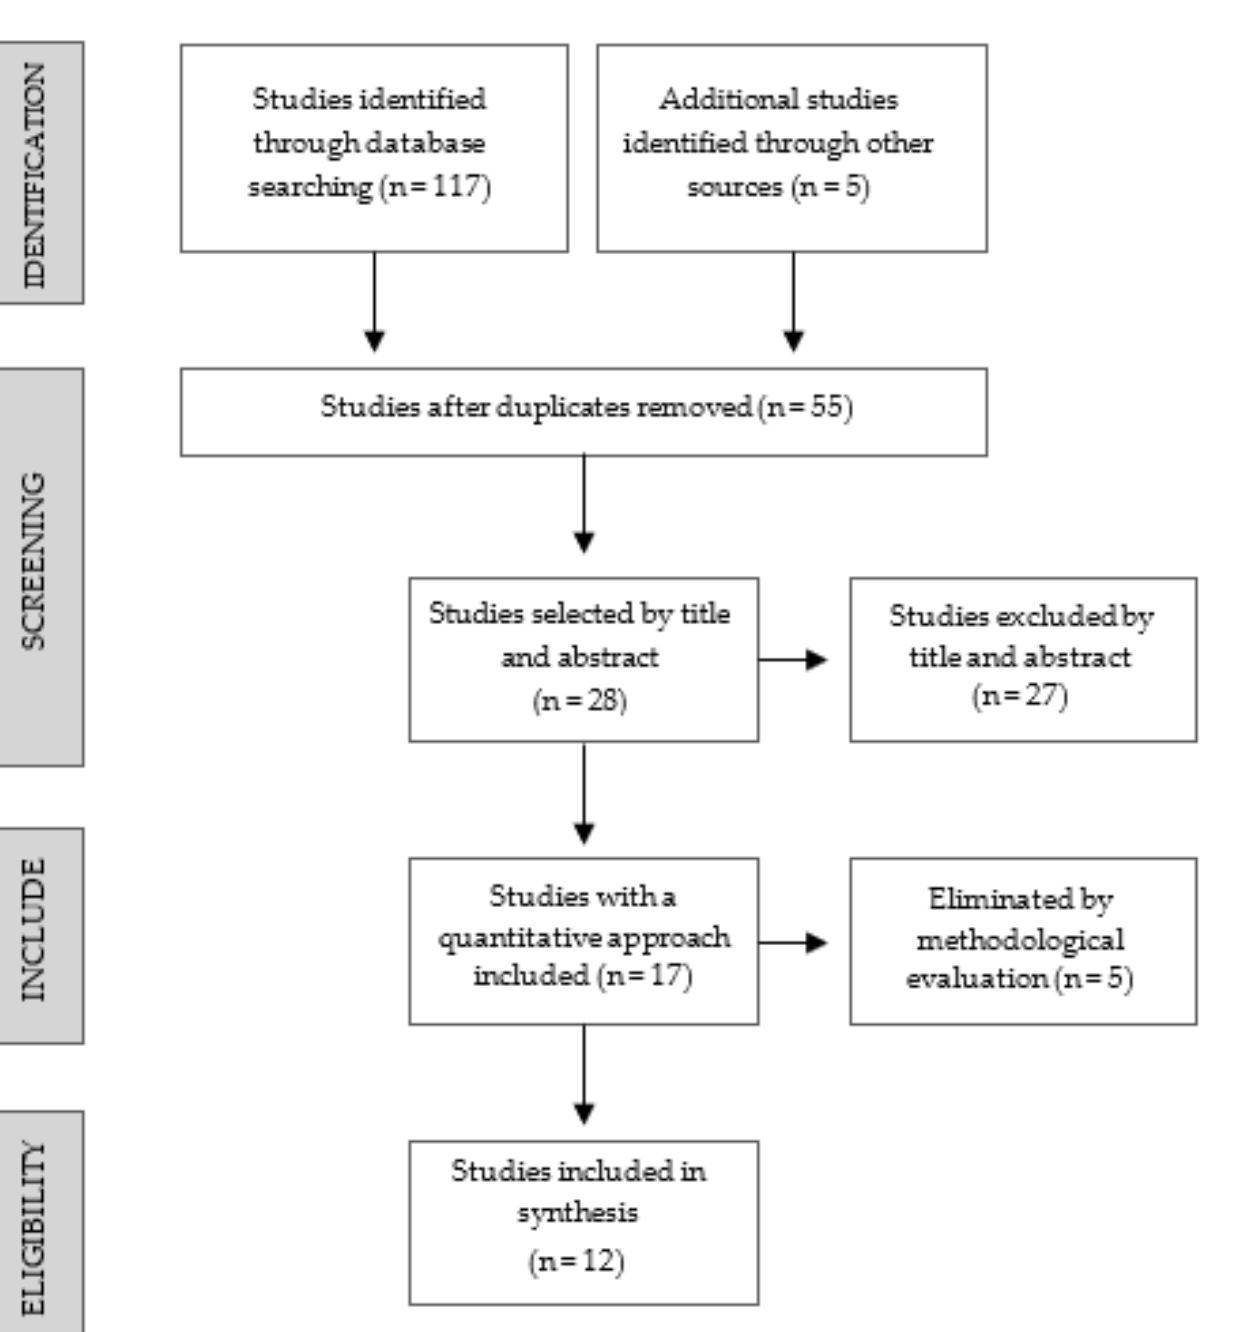
Figure 1. Study selection process according to the PRISMA Diagram.